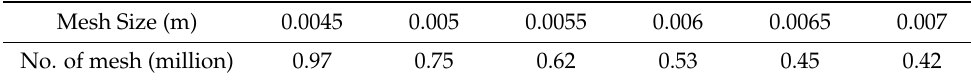
Table 2. Total mesh number of CFD